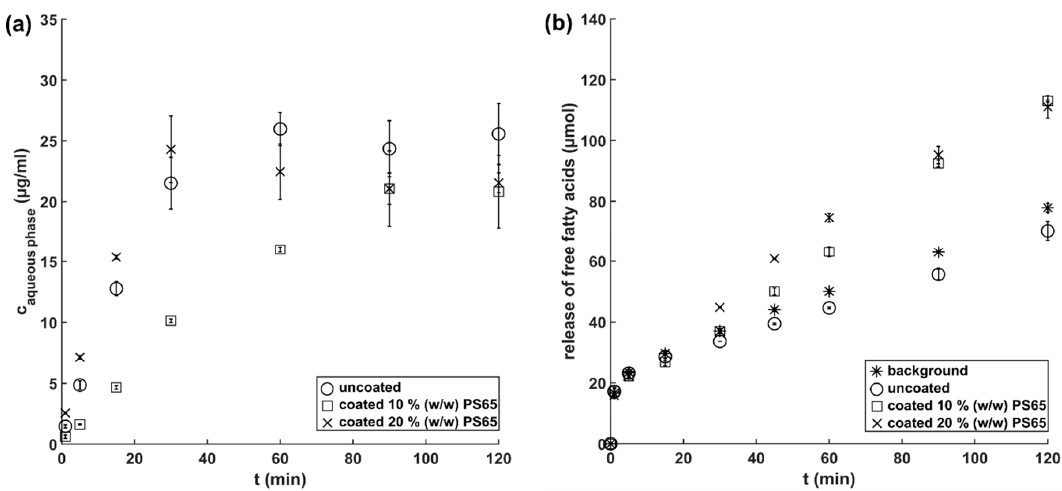
Figure 5. ( a ) Concentration of CRV in the aqueous phase of the lipolysis medium and ( b ) release of FFA during dynamic in vitro lipolysis of uncoated amorphous CRV particles (circle) and coated amorphous CRV particles (10% ( w/w ) PS65 (square) and 20% ( w/w ) PS65 (cross)). The titration of FFA released during dynamic in vitro lipolysis of lipids present in blank FaSSIF is shown by the asterisk. Results are presented as mean ± SD ( n = 3).